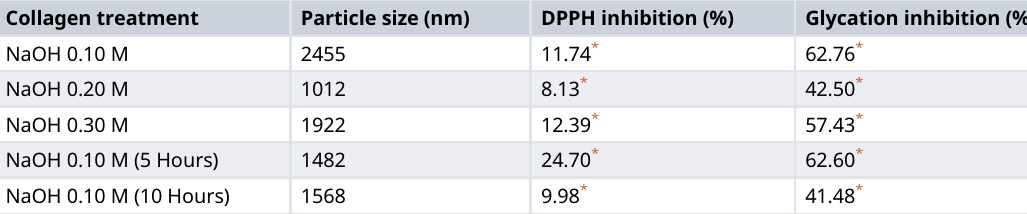
Table 4. Particle size, antioxidant activity and glycation inhibition Collagen treatment Particle size (nm)